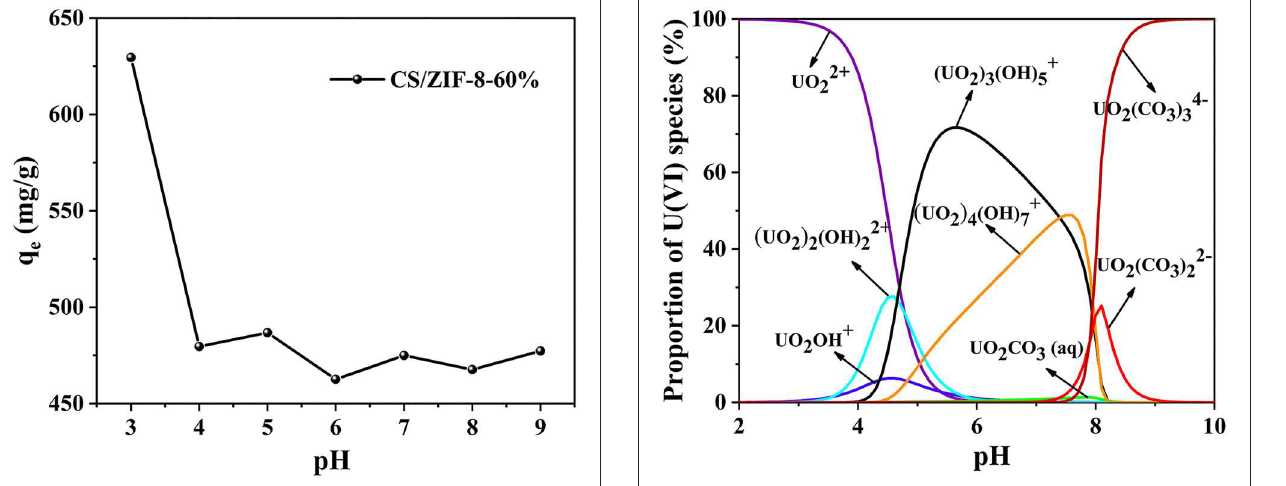
Adsorption Kinetics of the CS/ZIF-8 Composite